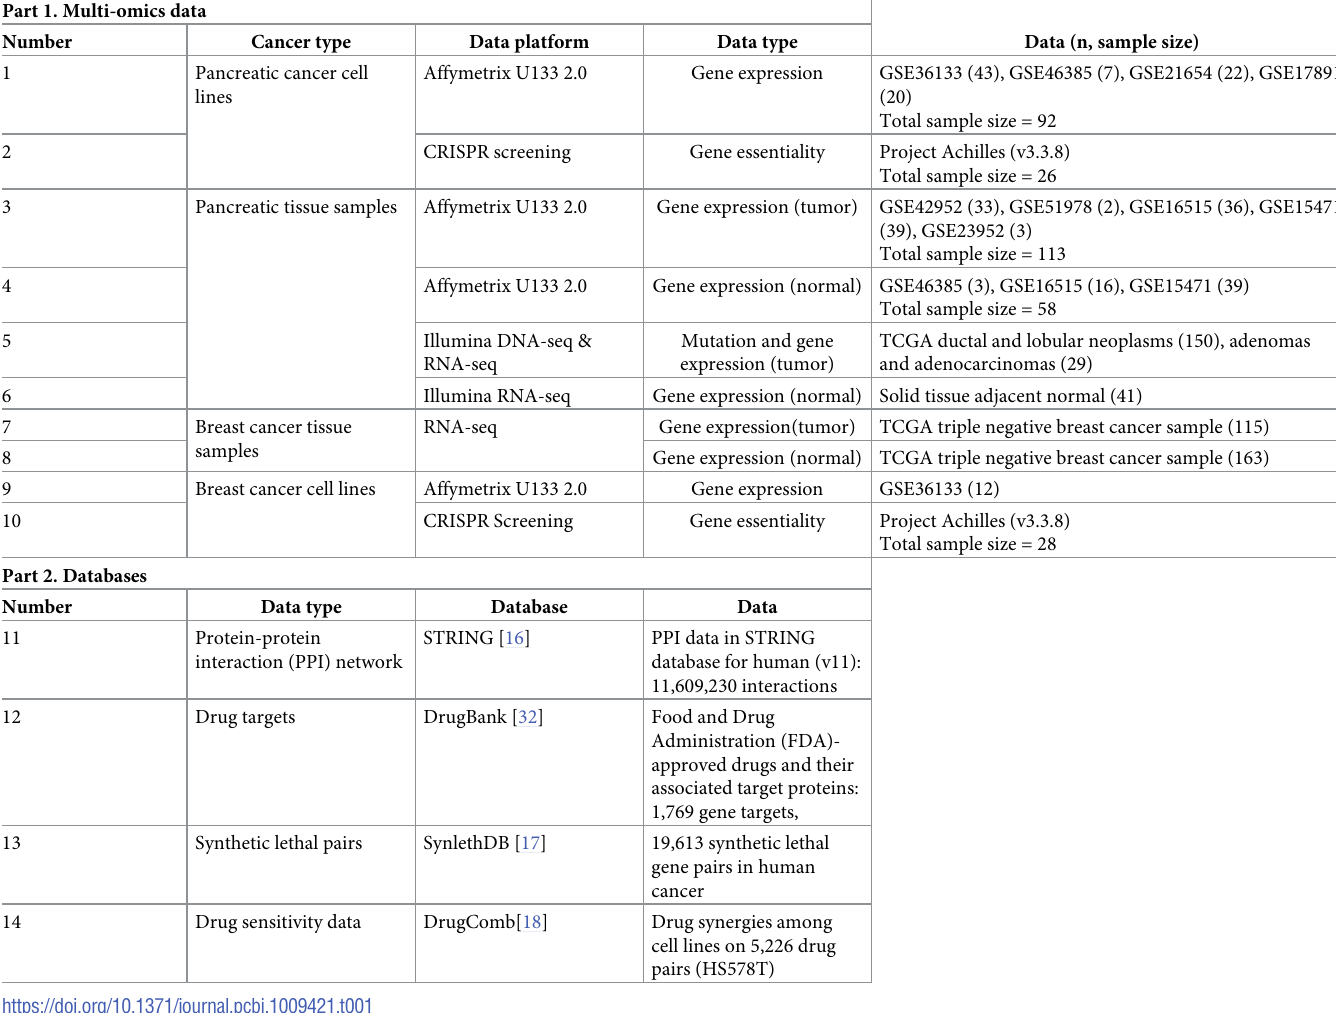
Table 1. Datasets used in this